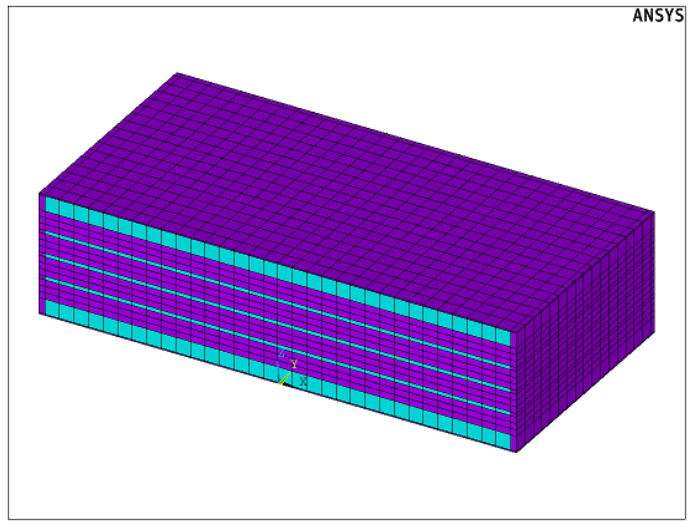
Figure 5. Half finite element model of elastomeric bearing (800 × 800 × 200 mm). The elastomeric bearing is a laminated structure of neoprene synthetic rubber and steel plate. In the experimental results for shear modulus in Section 2.3, it is confirmed that this value corresponds to an elastomer with a Shore hardness of 50A. Accordingly, the neoprene synthetic rubber with the shore hardness of 50A was used for the elastomeric bearings in this analysis, and S355 structural steel was used for the steel plate [12,20]. The mechanical properties for S355 structural steel are summarized in Table 4. The Mooney– Rivlin constants of the 2P, 5P, and 9P M-R models for the neoprene rubber are provided in Table 5, and the material behavior curve for the Mooney–Rivlin hyperelastic model is shown in Figure 6. Table 4. Mechanical properties for S355 structural steel (EN 10025-2).